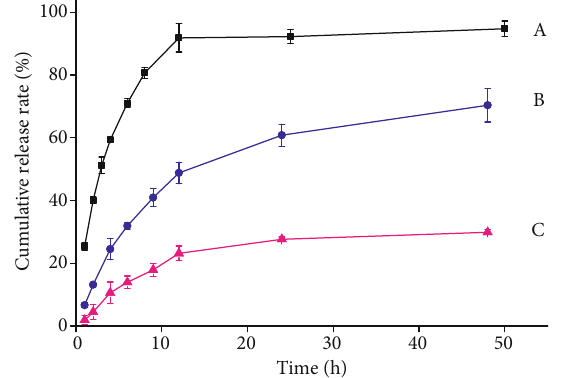
Figure 8: TEM photograph of the LDH host (a) and GA-LDH/LS (b). Table 1: Equation fi tting of the drug release in vitro.